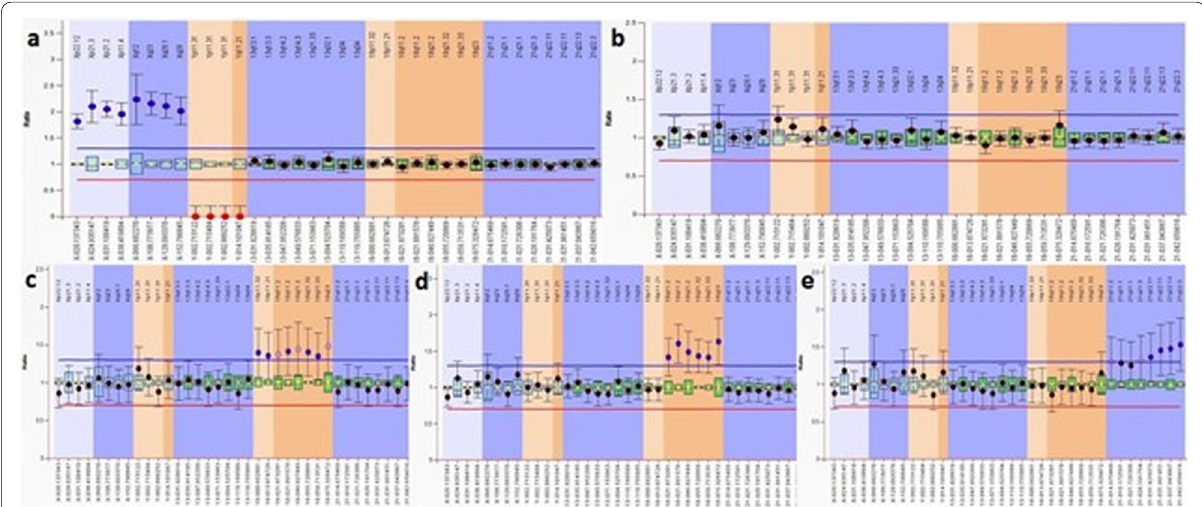
Fig. 1 Ratio charts of the MLPA results for some AF samples using SALSA MLPA Probemix P095 aneuploidy. Probe ratios of < 0.7 (red line) or > 1.3 (blue line) are usually regarded as indicative of a deletion or duplication, respectively. a XX sample with no trisomy for 13, 18, and 21; b XY sample with no trisomy for 13, 18, and 21; c XY sample having trisomy 18; d XY sample having trisomy 18q; e XY sample having trisomy 21